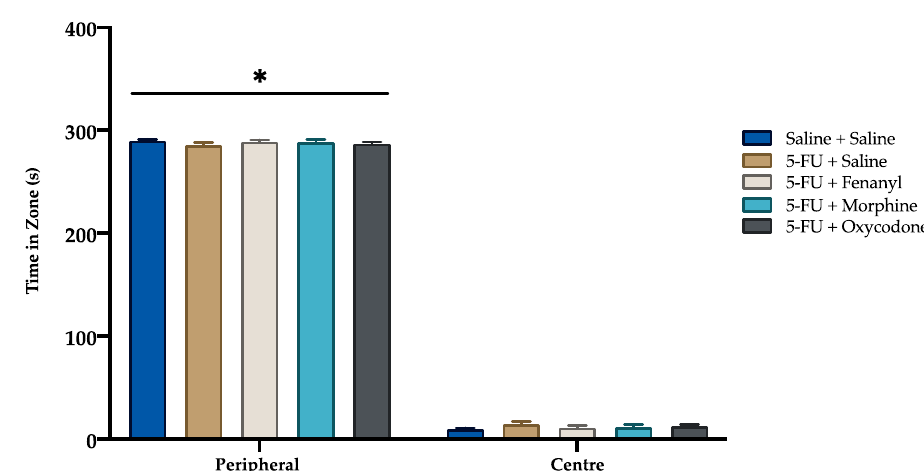
Figure 5. Time spent in center and peripheral zones of the open field test. Data presented as mean ± SEM. * p < 0.05 compared to center zone. Saline + Saline (n = 11), 5-FU + Saline (n = 12), 5-FU + Fentanyl (n = 12), 5-FU + Morphine (n = 12) and 5-FU + Oxycodone (n = 12).